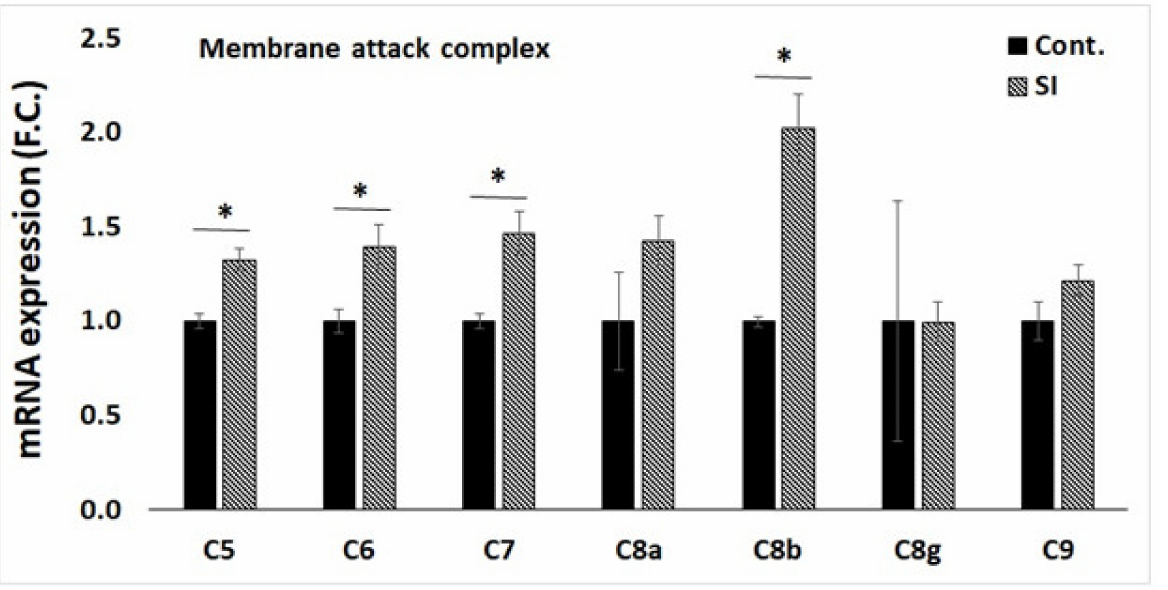
Figure 4. mRNA expression for MAC showed significant expression of C8 β . Data are shown as the mean ± standard deviation ( n = 3) after a two-tailed paired Student’s t -test (* p <